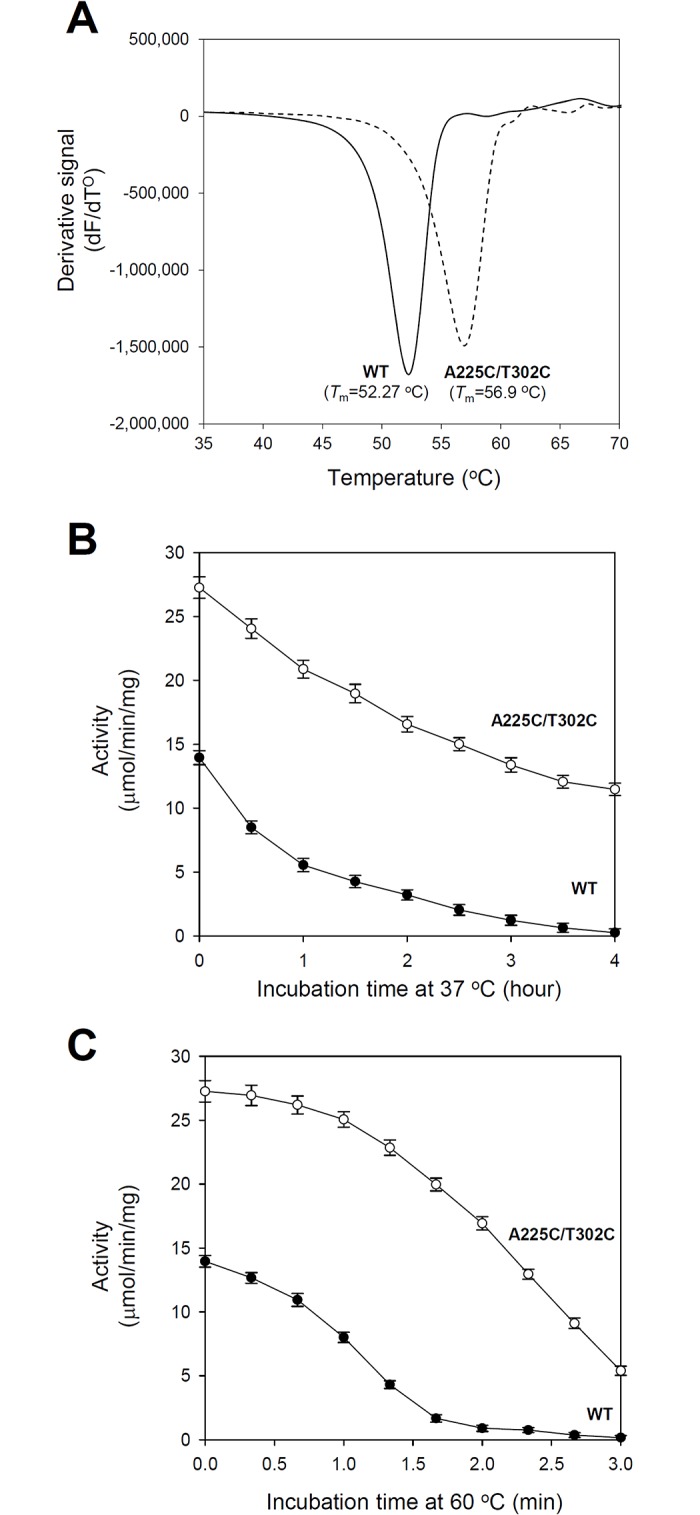
Comparison of resistance to temperature between SrLDCWT and SrLDCA225C/T302C.(A) Thermal stability measurement of SrLDCWT and SrLDCA225C/T302C. The Tm values of SrLDCWT and the SrLDCA225C/T302C mutant are displayed. (B) (C) Comparison of thermal stability between SrLDCWT and SrLDCA225C/T302C. The LDC activities of SrLDCWT and the SrLDCA225C/T302C mutant are measured using proteins pre-incubated at 37°C (B) and 60°C (C).